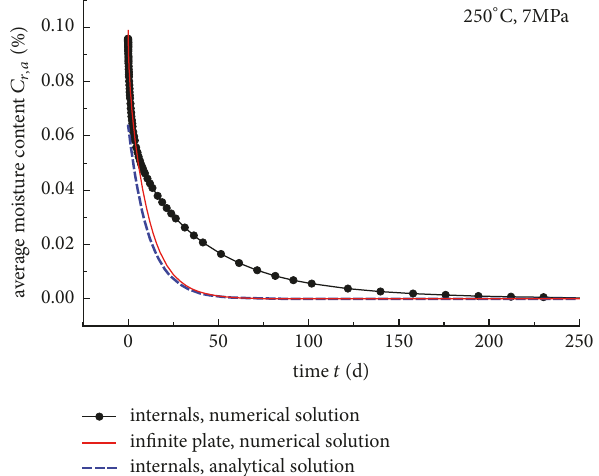
Figure 7: Comparison of analytical and numerical solutions.